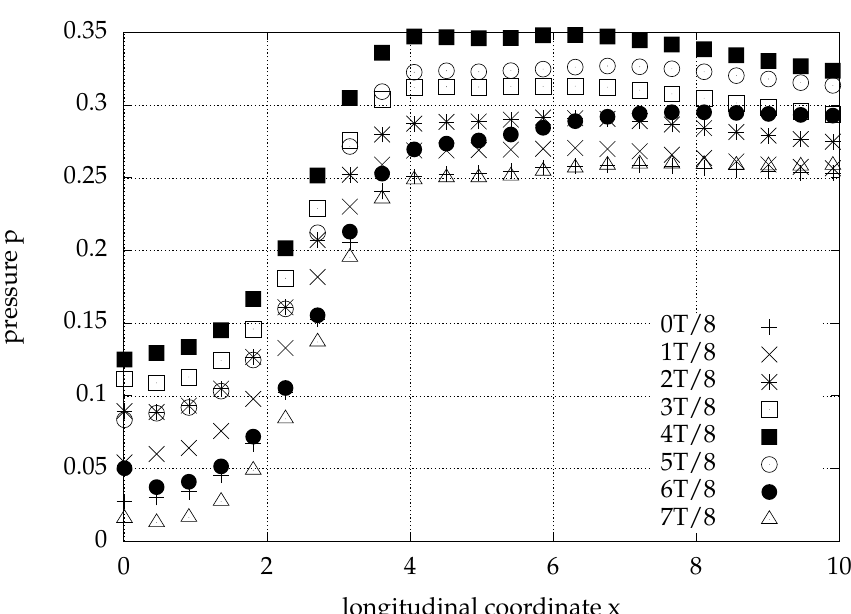
Figure 20. Pressure at the internal surface of an elastic control membrane with length l = 10, tension T m = 55 and external pressure exerted at its outer side, p e = 0.55 for eight instances during one inflow period T . The inflow is defined by Equation (1) with α = 0.05 and ω = 0.05.